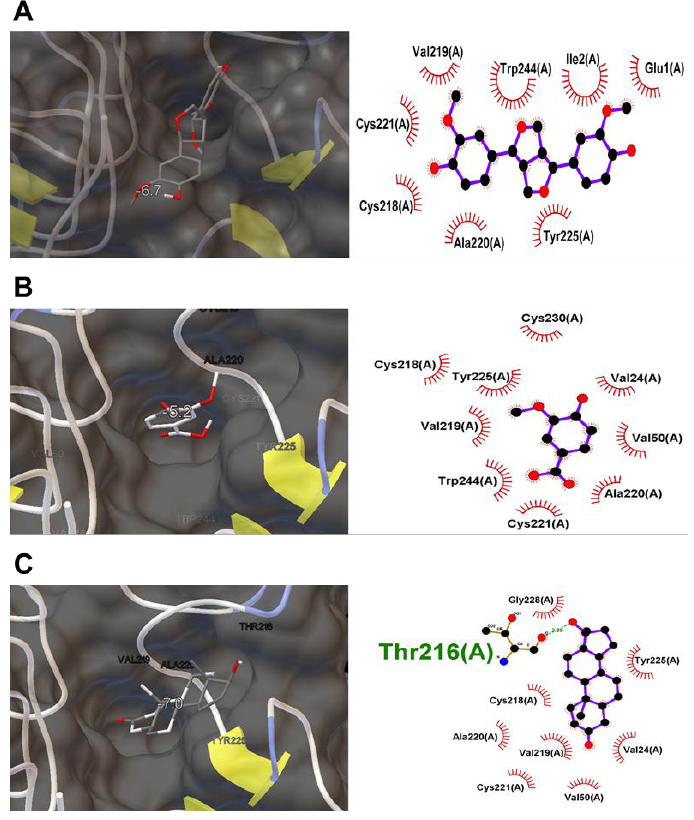
Figure 5. In silico molecular docking analysis for potential small molecules against IGF-1R protein. The left lane represents the interaction of small molecules at the binding site of IGF-1R. The right lane indicates a 2D map of the interactions between small molecules and IGF-1R, including amino acid residue, sequence number and chain. The red lines display hydrophobic interaction, while the green line displays the hydrogen bond. The molecules binding IGF-1R and respective binding energy is as follows: ( A ) Pinoresinol with binding energy −6.7 Kcal/mol, ( B ) Vanillic acid with binding energy −5.2 Kcal/mol, and ( C ) DHT with binding energy −7.0 Kcal/mol.